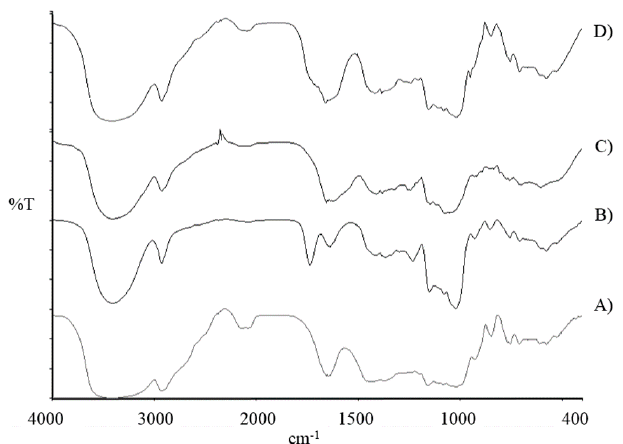
Figure 1. Fourier Transform–Infrared Spectrum of ( A ) pullulan: 3410 (-OH), 2928 (C-H), 1648 (C-O-C) cm − 1 ; ( B ) carboxyethyl-pullulan: 3402 (-OH), 2930 (C-H), 1736 (O-C=O), 1638 (C-O-C) cm − 1 ; ( C ) carboxyhydrazide-pullulan: 3400 (-OH), 2929 (C-H), 1655 (N-C=O), 1638 (C-O-C) cm − 1 ; ( D ) pullulan-dexamethasone: 3408 (-OH), 2926 (C-H), 1654 (-C=O-NH-N=C), 1637 (C-O-C) cm − 1 . %T = Transmittance in percentage.